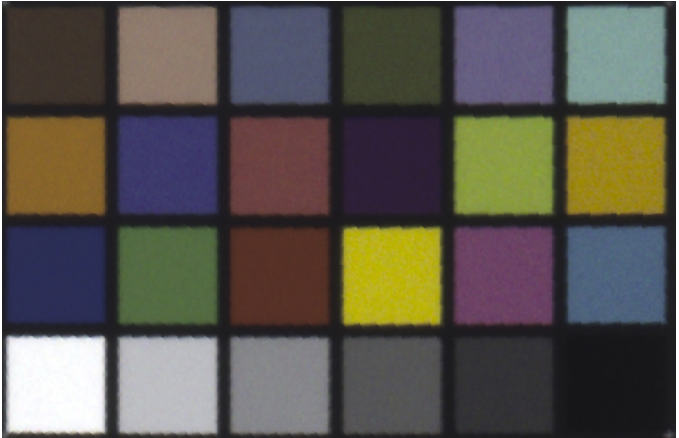
Figure 5. The color target cropped from the panoramic image captured with the TLS instrument.